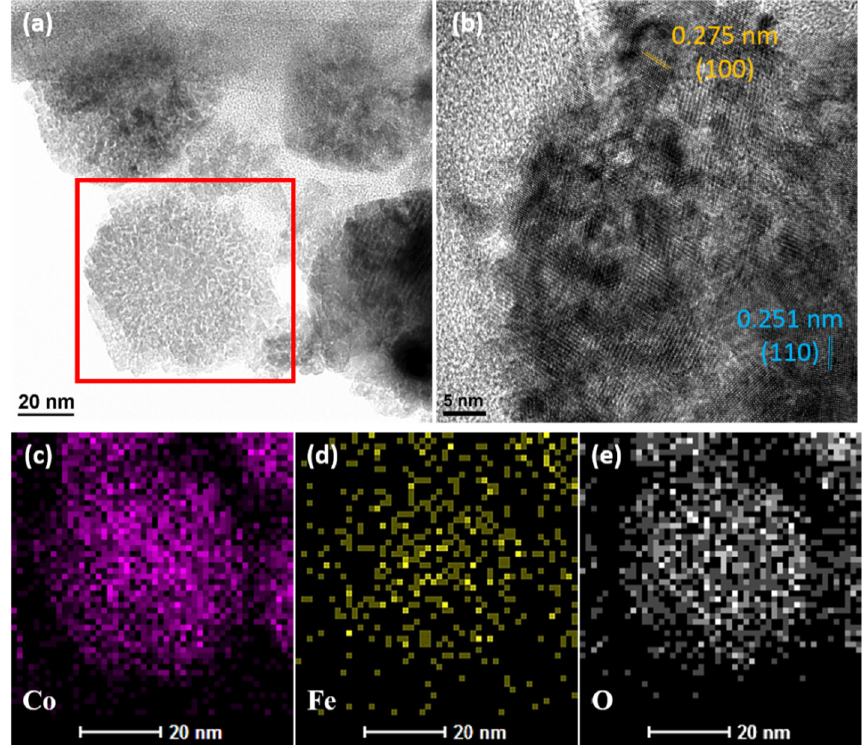
Figure 6. The TEM for Co-Fe 2 O 3 (60:3). ( a ) The morphology of island-type hybrid catalysts. ( b ) The HRTEM of island-type hybrid catalysts. The EDS mapping for ( c ) cobalt, ( d ) iron, ( e ) oxygen.